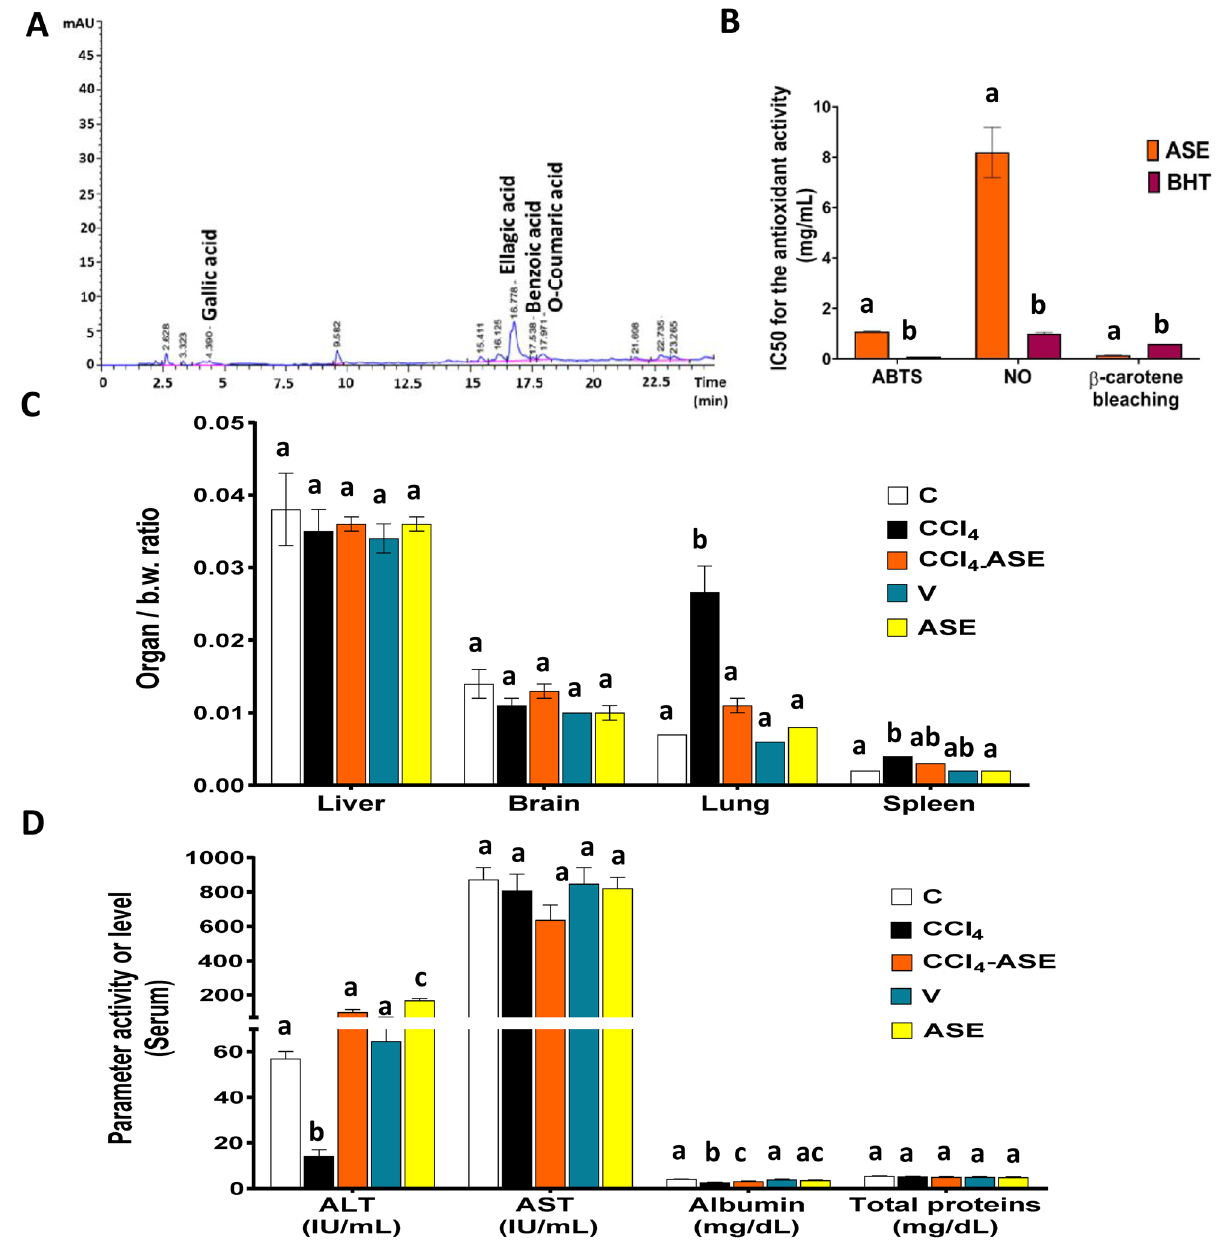
Figure 1. In vitro characterization of ASE, organ weights, and serum analysis of rats in all the studied groups. ( A ) HPLC analysis of the ASE. ( B ) in vitro antioxidant activities of ASE using three different antioxidant systems ( C ) organ weight/body weight (b.w.) ratio. ( D ) liver function parameters in the serum of rats. Results are expressed as mean ± S.E of 7 animals. C control untreated rats, V olive oil (vehicle of CCl 4 )-administered rats (0.5 ml/kg b.w., ip, 6 times), CCl 4 rats with systemic toxicity induced by CCl 4 injection (1 mL/kg b.w., ip, 6 times); CCl 4 -ASE , rats with systemic toxicity after their oral treatment with ASE (7.5 g/kg b.w.) for 10 days. ASE , normal rats were administered only ASE (7.5 g/kg b.w.) for 10 days. Different letters refer to the significance at P < 0.05; CCl 4 -ASE group was compared with the CCl 4 group, while V and ASE groups were individually compared with the C group. ABTS 2,2 ′ -azino-bis (3-ethylbenzothiazoline-6-sulfonic acid),